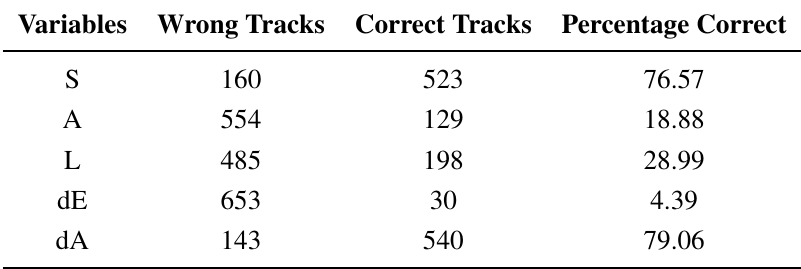
Table 3. Contribution of structure, amplitude, location, eccentricity difference and areal difference (SALdEdA) variables in storm tracking; the total number of tracks is